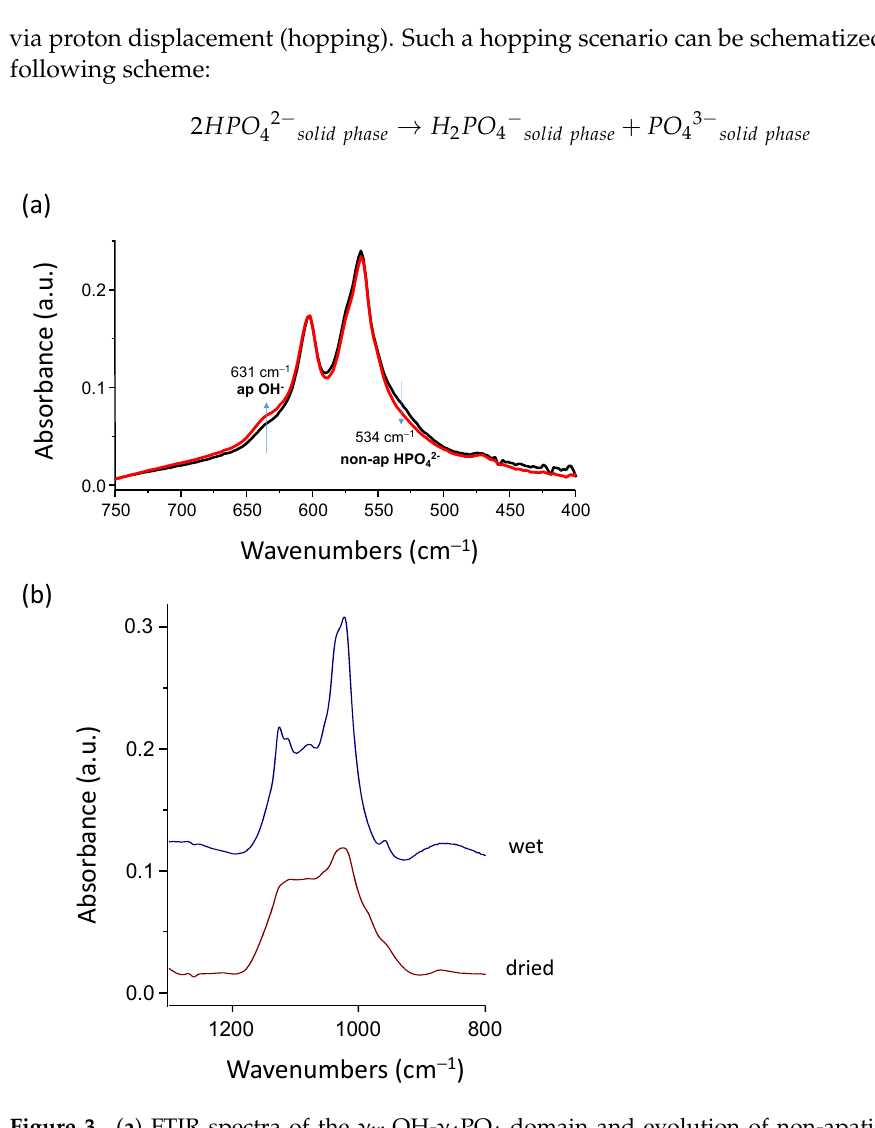
Figure 3. ( a ) FTIR spectra of the ν lib OH- ν 4 PO 4 domain and evolution of non-apatitic HPO 42 − and apatitic OH − contents (from spectral decomposition) before (black line) and after (red line) re-immersion of hap-1d in aqueous solution (initial pH 7.4, ~150 min re-immersion); ( b ) FTIR analysis of hap-20 sample in the wet and dry states in the ν 3 PO 4 domain.